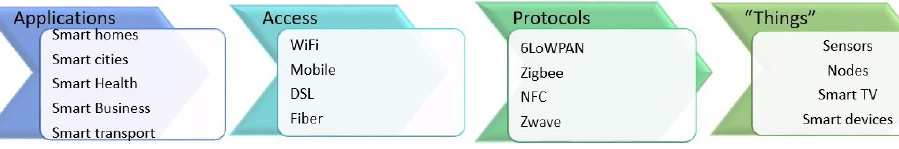
Figure 1. IoT applications and